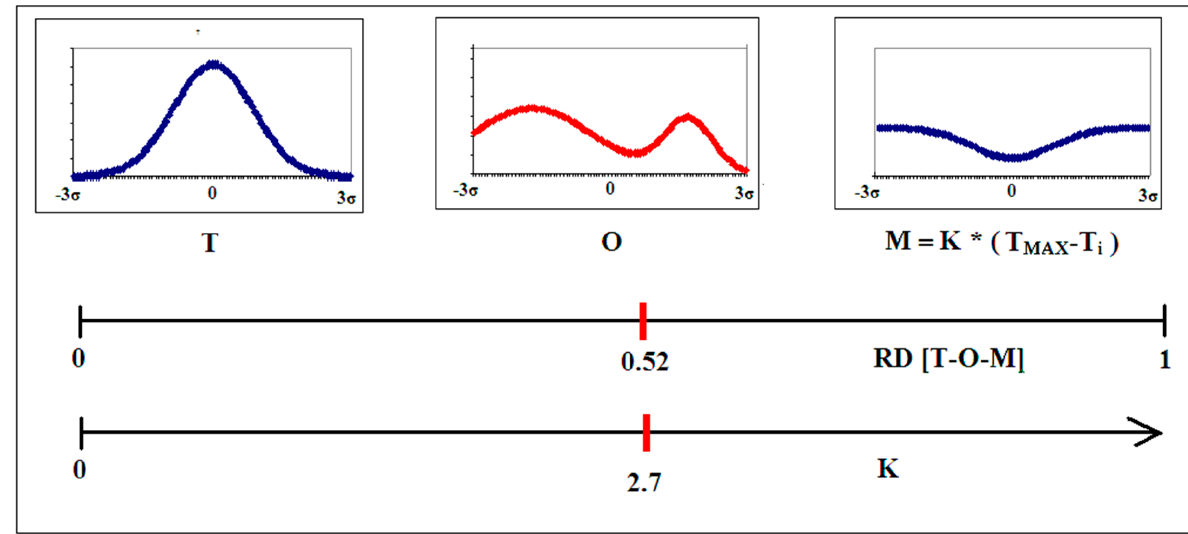
Figure 3. Introduction of the reference distribution M taking into account the degree of involvement of factors other than polar water. Central axis—axis of the RD value for the T–O–M system, where the RD value is given which defines the status of the O distribution against the given reference distributions. The lower axis shows the scale of the K value—K corresponding to the distribution status O is marked. It should be noted that to facilitate the readability of the described model, a simplification in the form of a one-dimensional Gaussian function analysis was used, while the 3D Gaussian distribution is used for the description of proteins.